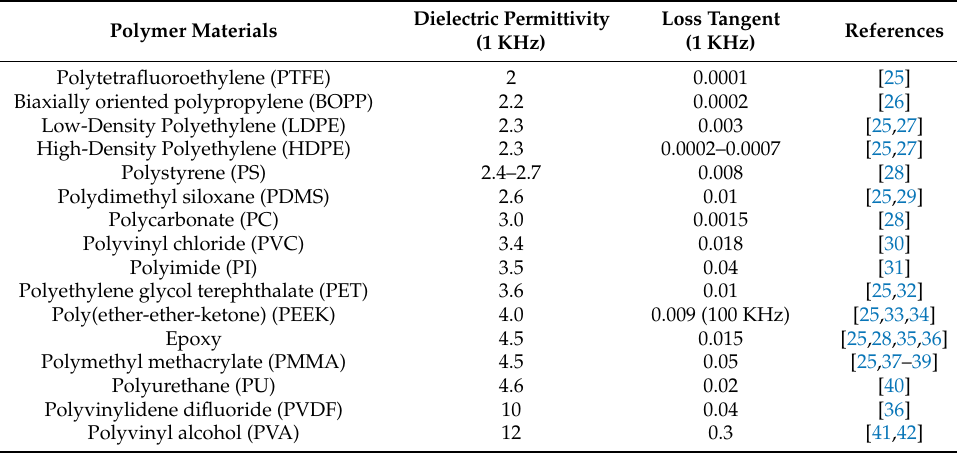
Table 1. Dielectric properties of various polymers